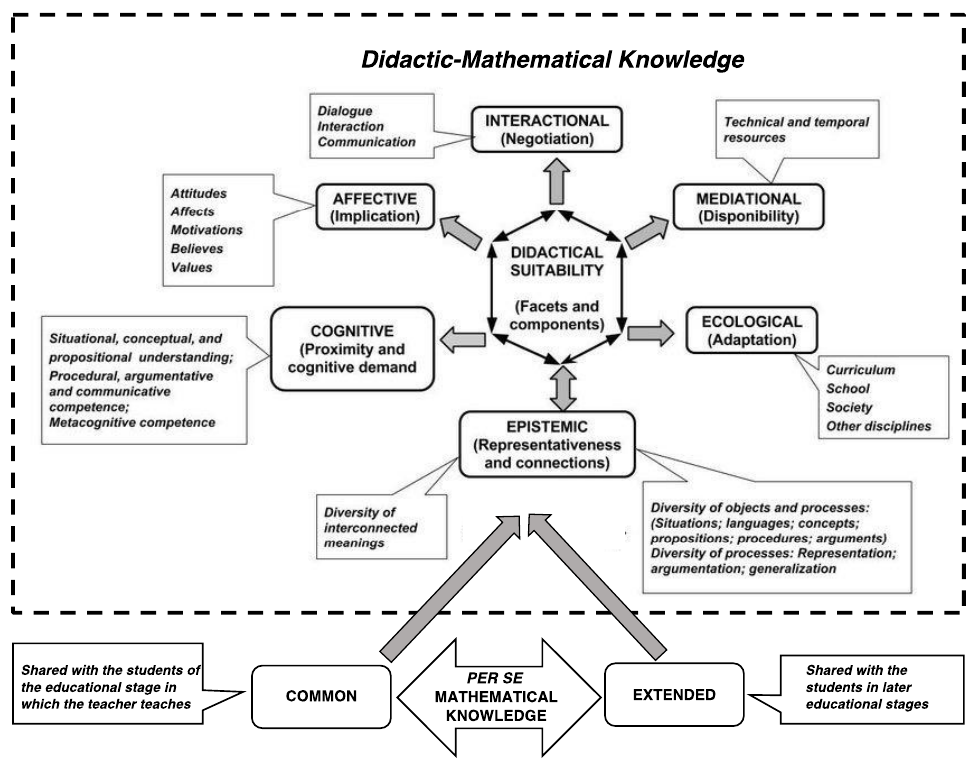
Figure 1. Facets and components of the teacher knowledge [34] (p. 292).